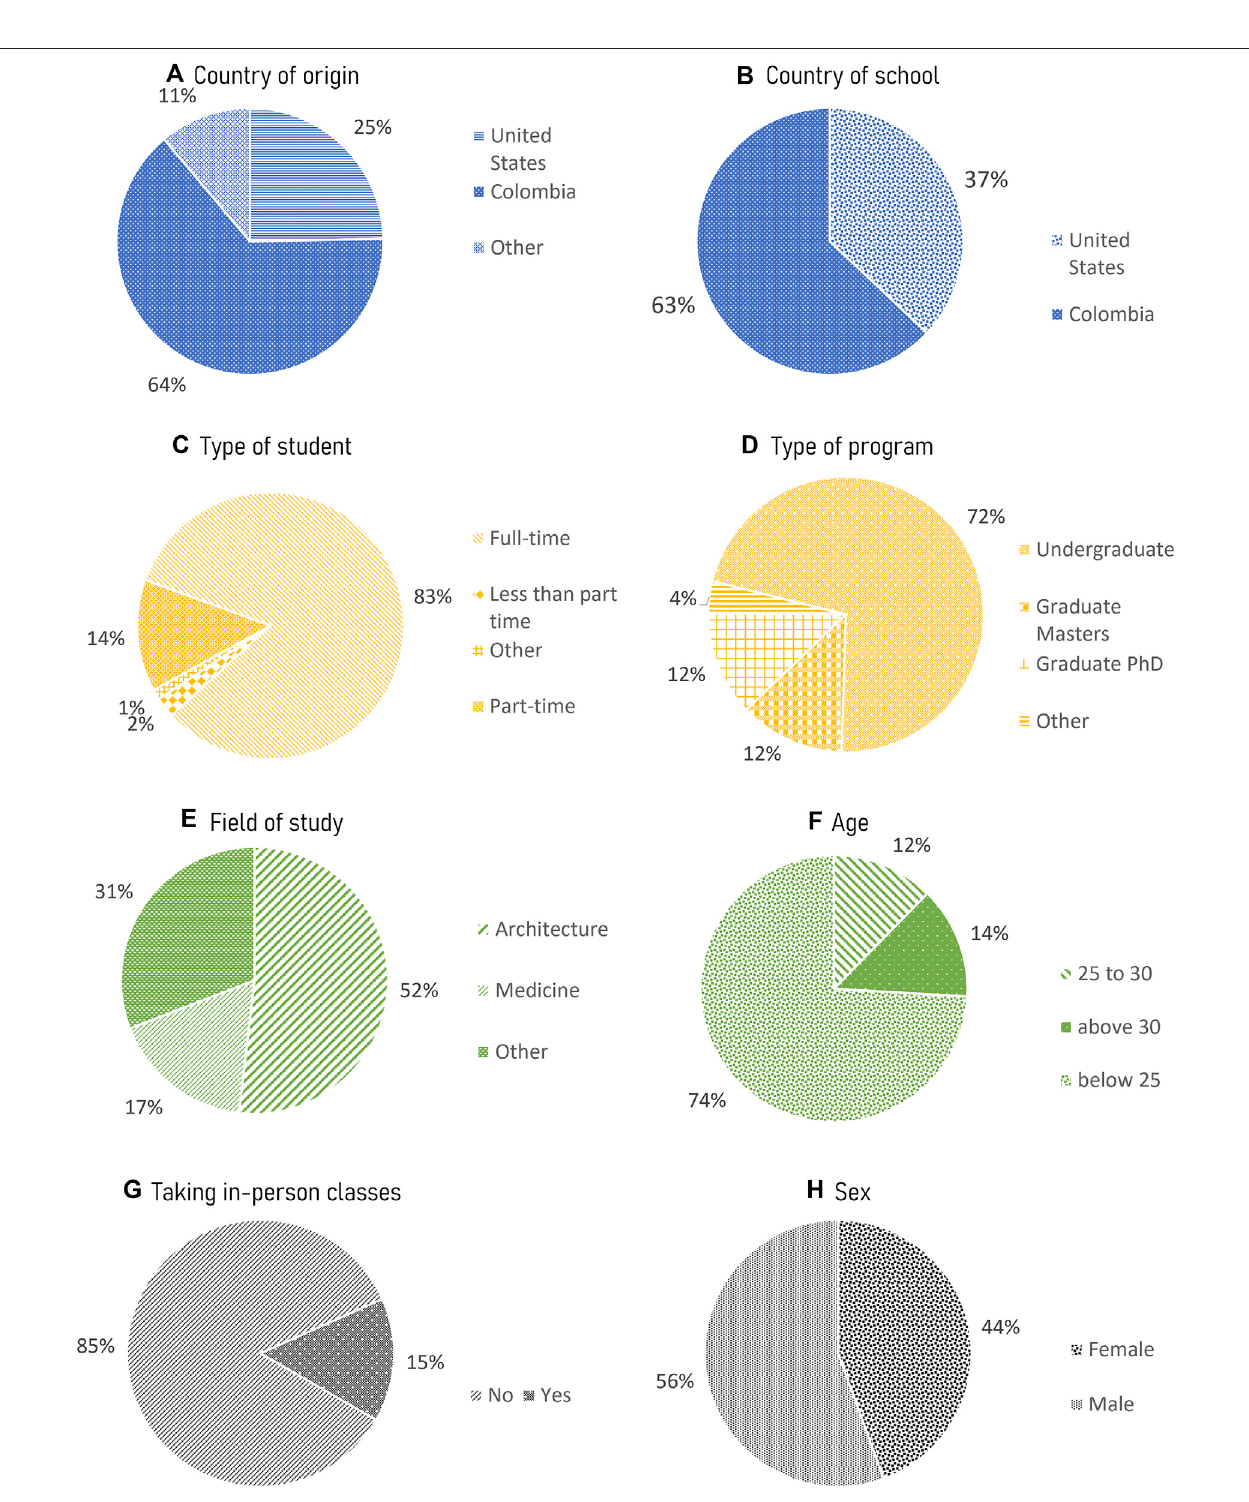
FIGURE 3 | Characteristics of the sample: (A) Country of origin, (B) Country of school, (C) Type of student, (D) Type of program, (E) Field of study, (F) Age, (G) Taking in-person classes, (H) Sex.